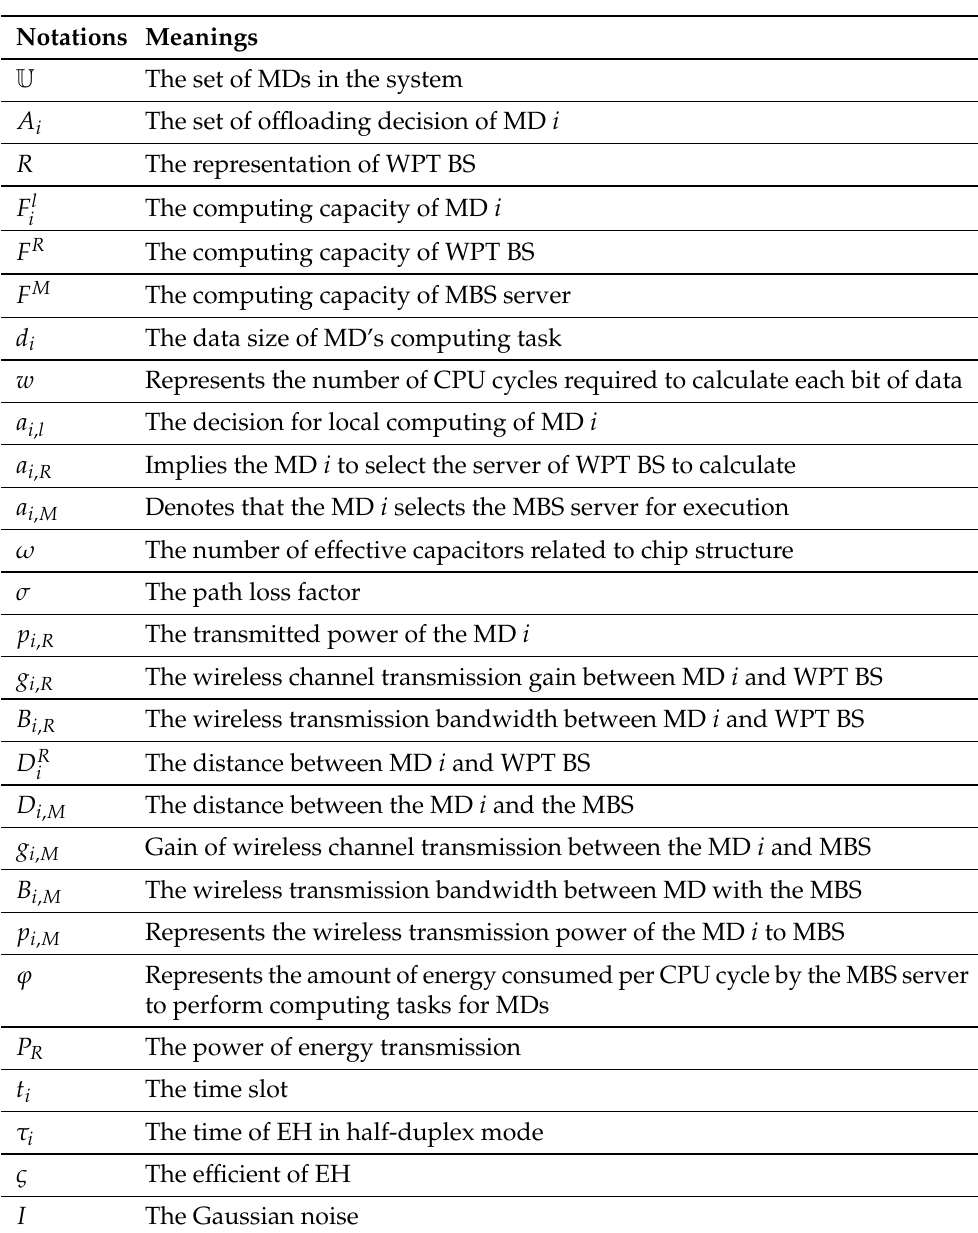
Table 1. Summary of the key